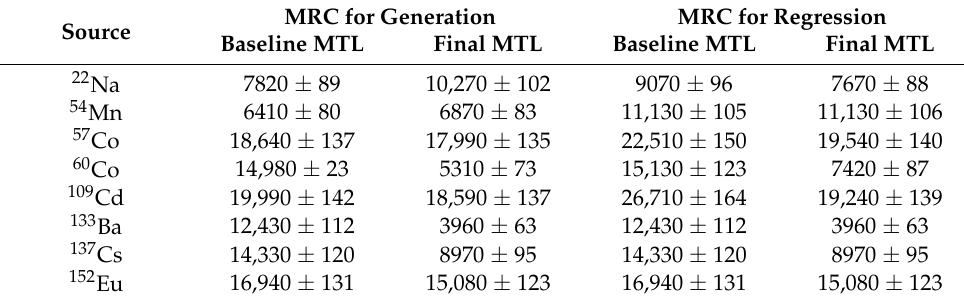
Table 4. Evaluated minimum required counts (MRCs) of both models for the generation and regres- sion